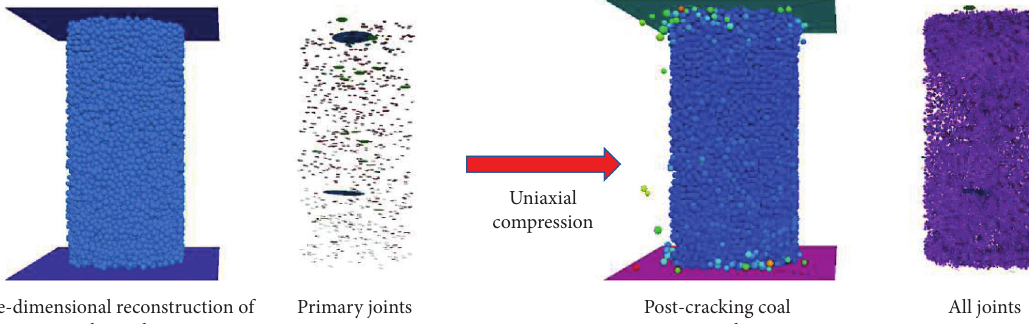
Figure 13: Numerical simulation test of uniaxial compression.